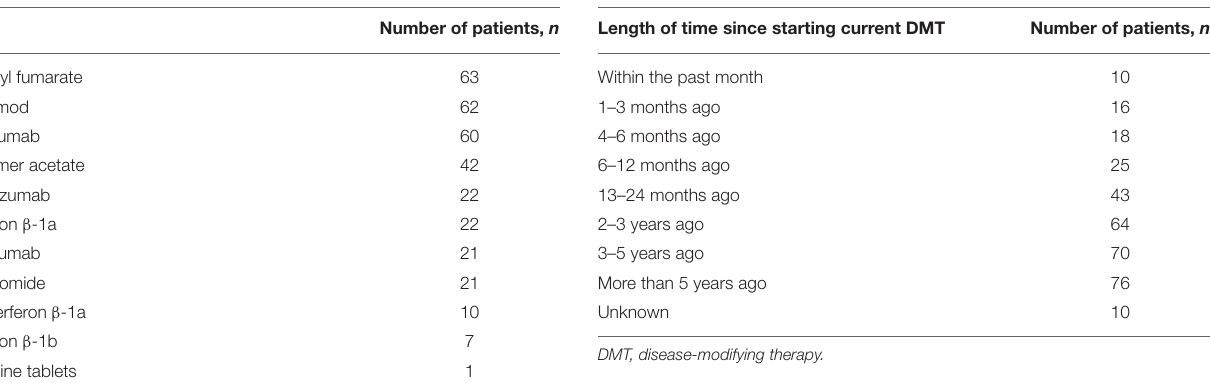
TABLE 1 | Current use of DMTs among survey participants ( N = 332). TABLE 2 | Length of time on current DMT among survey participants ( N =